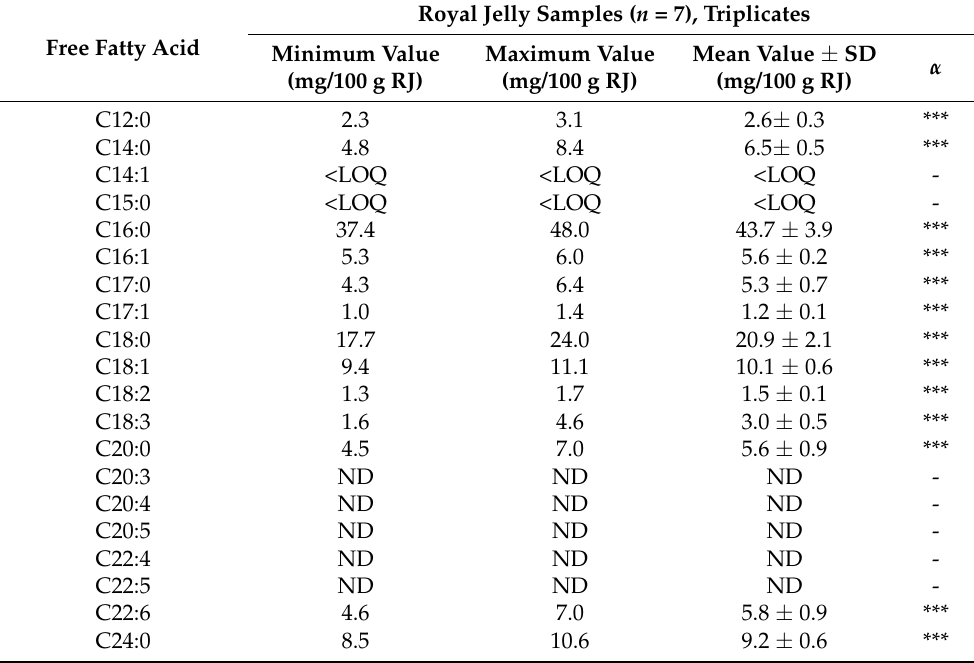
Table 1. Contents of common long-chain FFAs in RJ samples (mg/100 g fresh RJ).